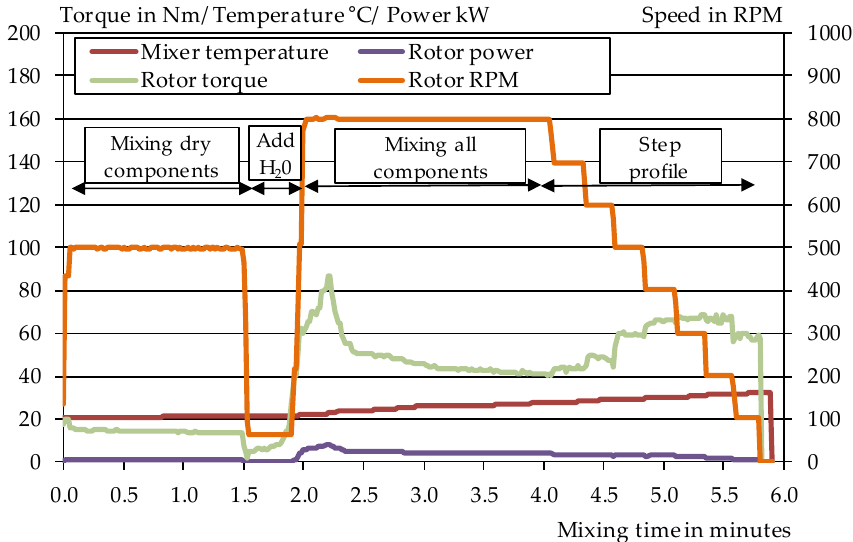
Figure 1. Mixing process of the extruded mortar using mix 1. On the primary Y-axis, the measured rotor torque, the temperature in the mixer and the motor power are shown. For a better overview, the present RPM of the rotor over the mixing time is shown on the secondary axis. The recorded data from each mix was ana- lysed and should give an initial indication of the consistency of the extremely stiff con- crete. The mixing regime was kept the same for all of the mixtures.